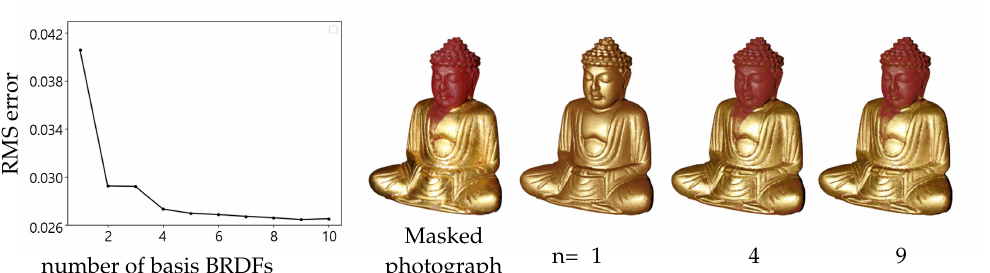
Figure 8. ( left ) RMS error between reconstructions and photographs according to the number of basis BRDFs. ( right ) corresponding reconstruction result for the ground